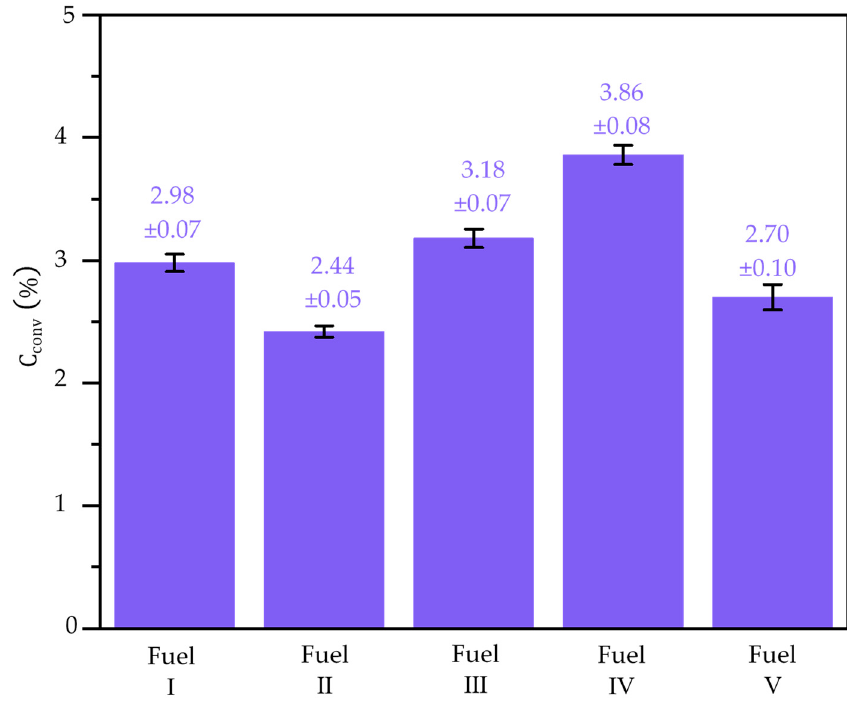
Figure 9 . Average carbon conversion for the five fuels I–V. Figure 9. Average carbon conversion for the five fuels I–V.